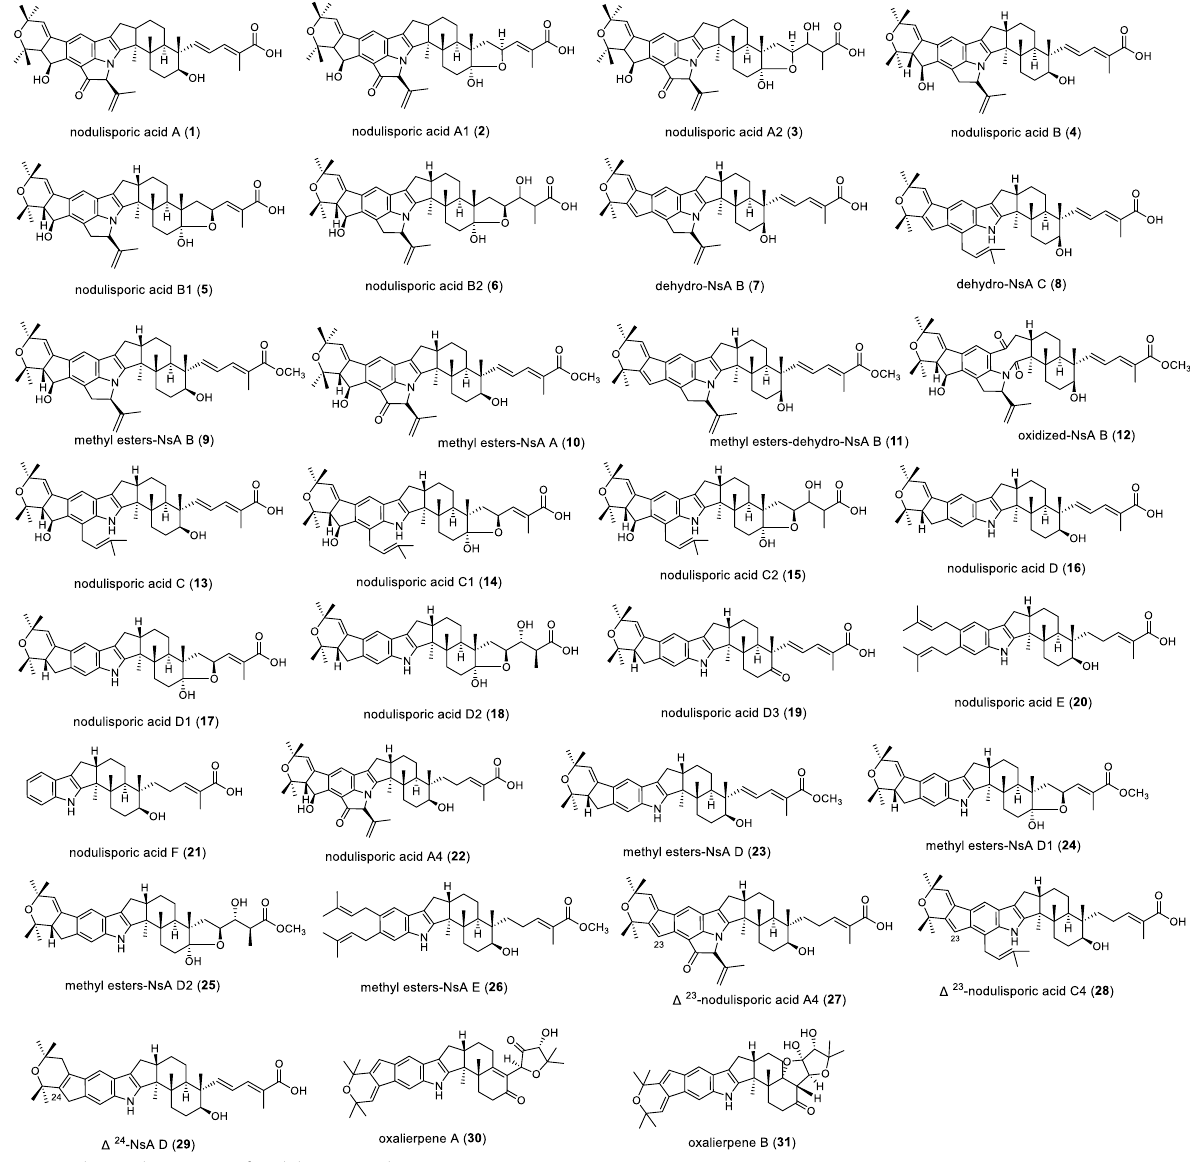
Fig. 1 Chemical structures of nodulisporic acid